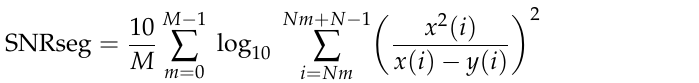
Figure 7. Comparison of SNR (dB) between the proposed cryptosystems.